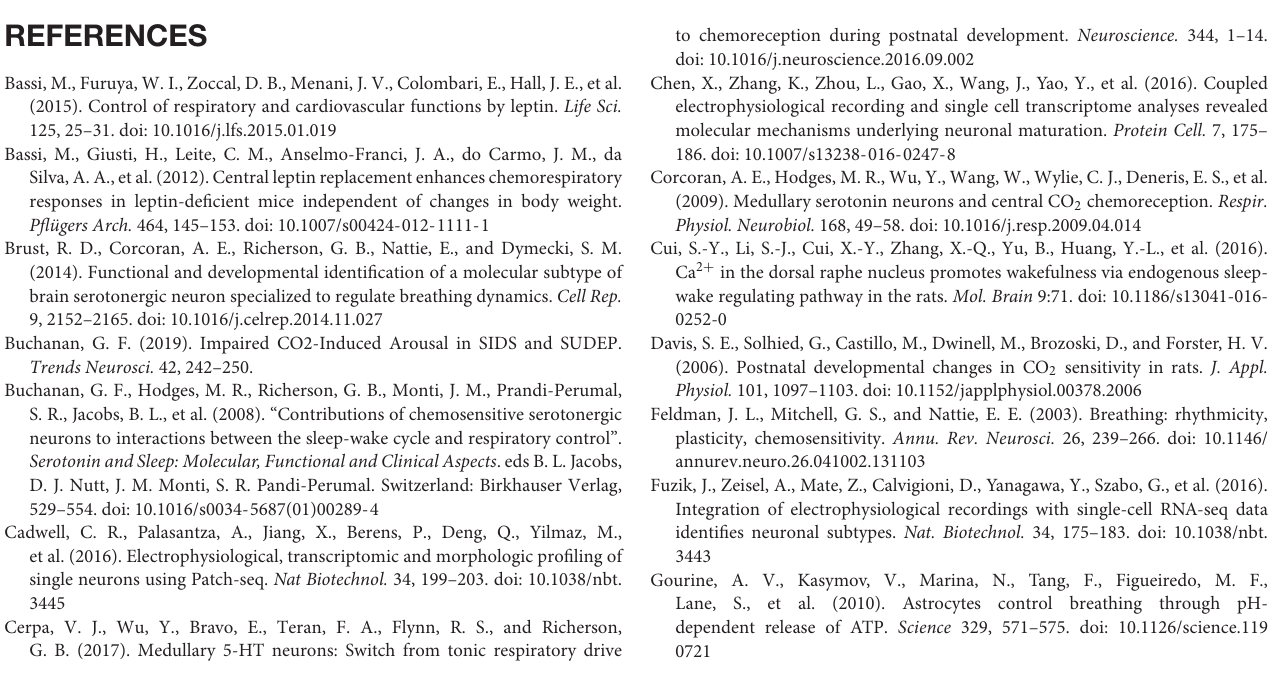
has high sensitivity and specificity with predictive accuracies (area under the curve) in determining if a 5-HT neuron is CO 2 sensitive. With lower baseline firing rates, the predictive accuracy for assessing the chemosensitivity phenotype of 5-HT neurons increases (H,J) . ** p < 0.01, *** p < 0.001, **** p < 0.0001. Supplementary Figure 2 | Ingenuity pathway analysis (IPA) canonical pathways significantly represented, but not predicted to be activated, by the 166 differentially expressed genes between CO 2 sensitive and insensitive 5-HT neurons determined by q < 0.05 (A) . IPA canonical pathways significantly predicted to be down regulated (blue) or upregulated (orange) in CO 2 sensitive neurons versus CO 2 insensitive 5-HT neurons (B) . Supplementary Figure 3 | Top 10 differentially expressed genes (DEGs, top panel), CO 2 sensitive enriched genes (middle panel), and CO 2 insensitive enriched genes (lower panel). Data indicate most regularity in gene expression for CO 2 sensitive enriched genes compared to Top 10 DEGs and CO 2 insensitive enriched genes (i.e., CO 2 sensitive enriched genes are only expressed in CO 2 sensitive neurons). Supplementary Figure 4 | RNAScope immunofluorescence validates co-expression of CD46 in Tph2+ 5-HT neurons within the rat brainstem including the raphe magnus (RMg). 4x objective overlay z-stack image outlining an area of the RMg that includes Tph2-expressing (green) cells (brightness enhanced for visualization of tissue outline) (A) . Zoom in of RMg region outlined in (A) captured with a 20x objective showing Tph2+ (green; left), CD46 + (red; middle; contrast enhanced 40%), and an overlay (right; contrast enhanced by 40%) (B) . Inset in overlay is enhanced zoom of a single Tph2+ neuron identified by the white arrow. Percentage of RMg and all Tph2+ cell also expressing at least 1 CD46 pixel (C) . (A) Scale bar = 100 µ m, (B) scale bar = 50 µ m. Supplementary Figure 5 | RNAScope immunofluorescence validates co-expression of Iba57 in Tph2 + 5-HT neurons within the rat brainstem including the raphe magnus (RMg). 4x objective overlay z-stack image outlining an area of the RMg that includes Tph2-expressing (green) cells (brightness enhanced for visualization of tissue outline) (A) . Zoom in of RMg region outlined in (A) captured with a 20x objective showing Tph2+ (green; left), Iba57 + (red; middle; contrast enhanced by 40%), and an overlay (right; contrast enhanced by 40%). Inset in overlay is enhanced zoom of a single Tph2+ neuron identified by the white arrow (B) . Percentage of RMg and all Tph2+ cell also expressing at least 1 Iba57 pixel (C) . (A) Scale bar = 100 µ m, (B) scale bar = 50 µ